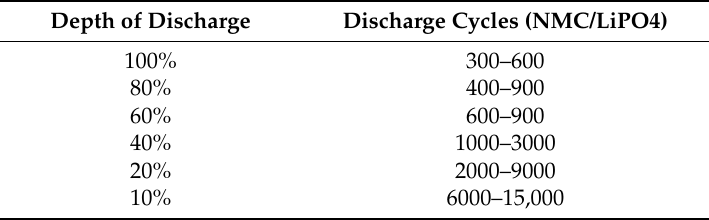
Table 3. Cycle life 1 as a function of Depth of Discharge